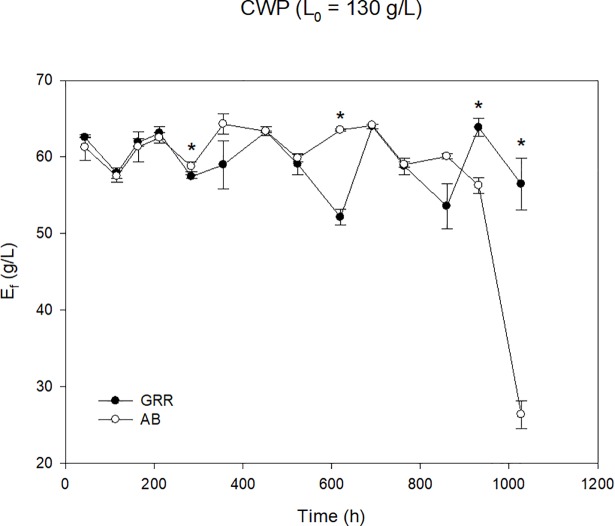
Evolution of ethanol concentration employing K. marxianus DSM 5422 on inorganic supports [glass Raschig rings (GRR) and alumina beads (AB)] during 14 fermentation cycles (Li = 130 g/L).Asterisks indicate the existence of significant differences (p < 0.05) between supports for a given batch.